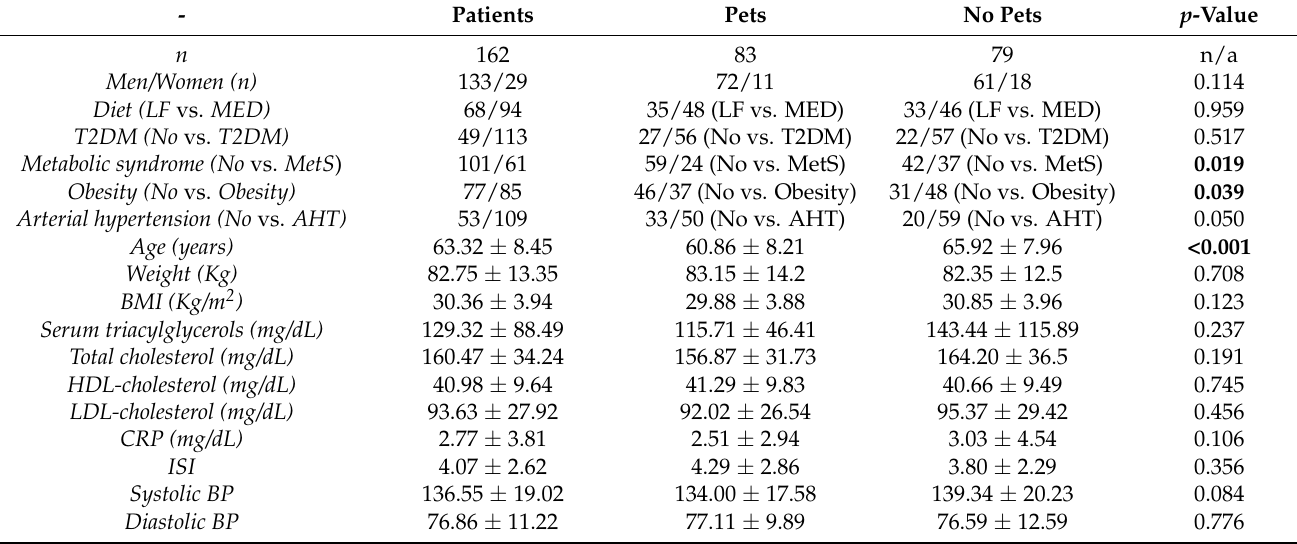
Table 1. Baseline characteristics of the participants in the study. Values correspond to the mean ± SD.